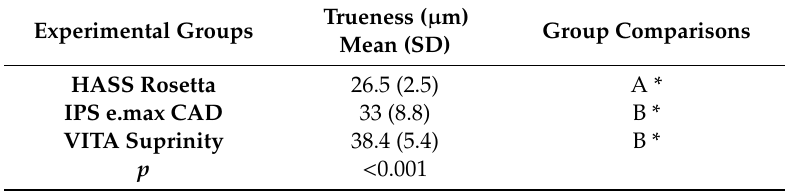
Table 2. Comparison of the trueness according to the type of lithium disilicate block.